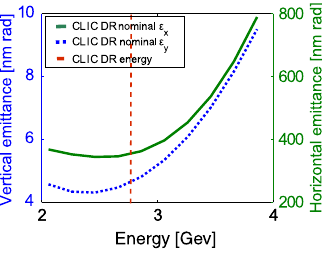
FIG. 5. Vertical and horizontal normalized emittances versus beam energy [2].